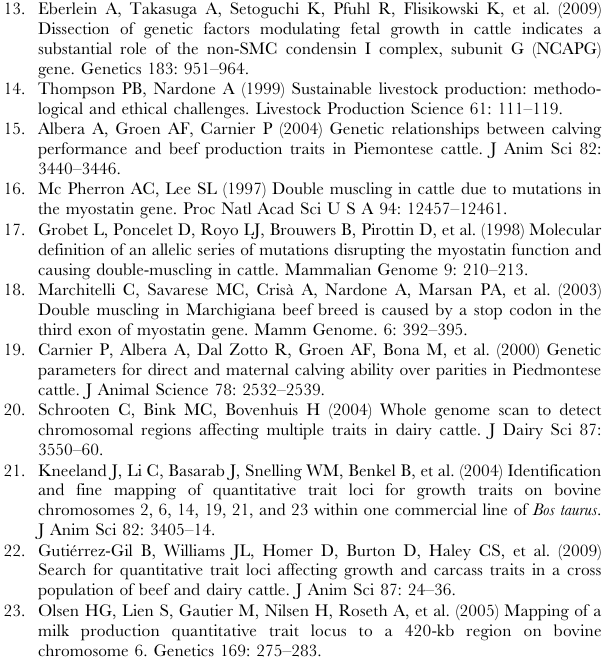
Figure S1 QQ-plot of significance levels for the GWAS scan prior to normalization. Table S1 Additional SNPs genotyped in the LAP3 , NCAPG and LCORL genes. The rs number, the gene region and the reference are